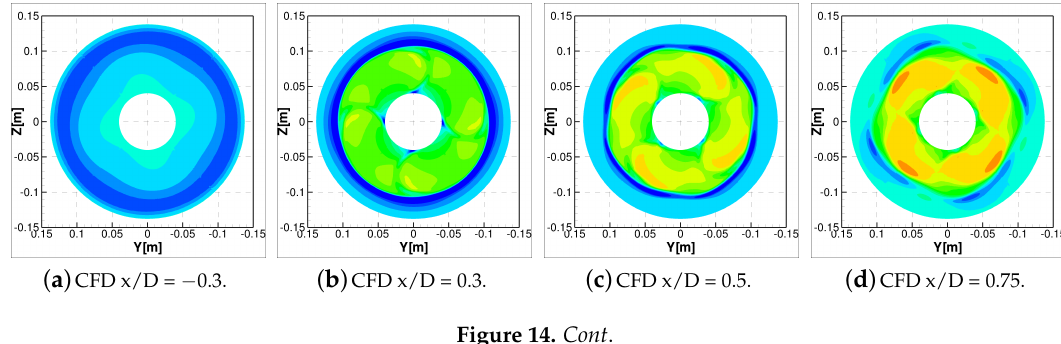
Figure 13. Radial ( V R ) and tangential ( V T ) non-dimensional velocity at 0.3 x/D transversal section without duct.